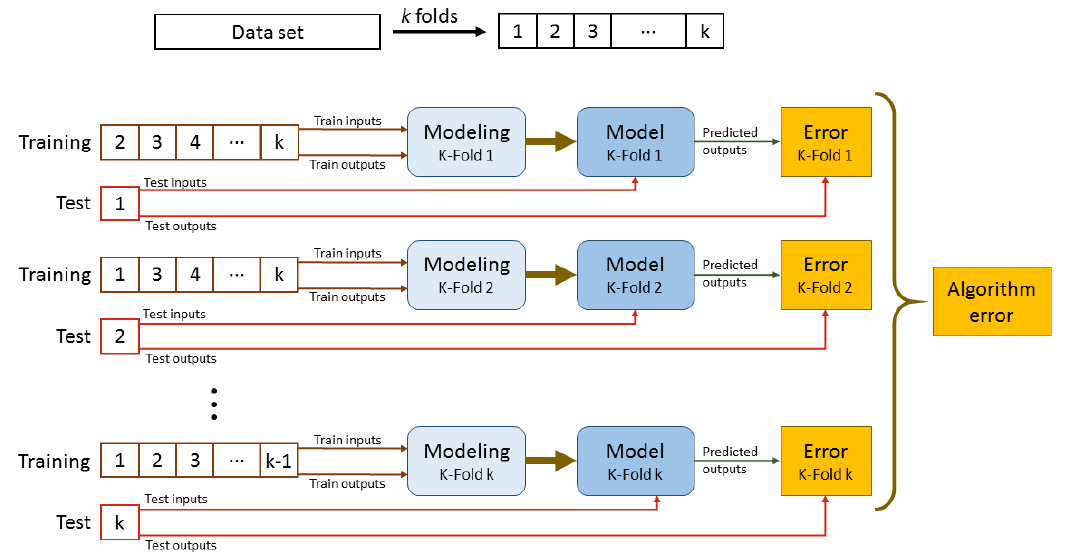
Figure 7. K-fold training and test data